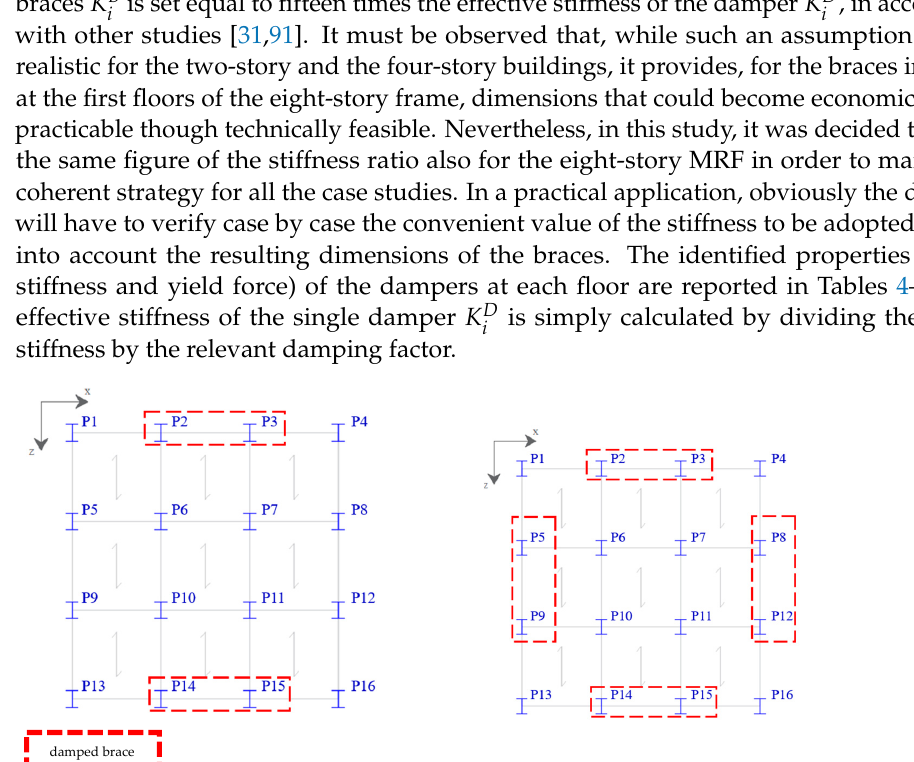
and yield force N D of the dampers at each story in yi yi